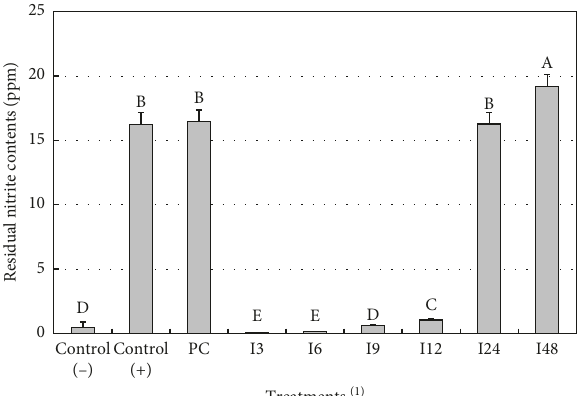
Figure 1: Changes of residual nitrite content of cooked cured pork loin with spinach juice and different incubating time. A − E Means with different letters are significantly different ( P < 0 . 05). (1) Control ( − ), curing meat with nitrite free; control (+), curing meat with 120ppm nitrite; PC, curing meat with preconverted nitrite source from spinach; I3,incubating for 3h curing meat with spinach and starter culture; I6, incubating for 6h curing meat with spinach and starter culture; I9, incubating for 9h curing meat with spinach and starter culture; I12, incubating for 12h curing meat with spinach and starter culture; I24, incubating for 24h curing meat with spinach and starter culture; I48, incubating for 48h curing meat with spinach and starter culture. (1) The difference between treatments was reported in the Materials and Methods section. Table 4: Changes of sensory evaluation of cooked cured pork loin with spinach juice and different incubating time. Treatments (1) Color Flavor Chewiness Overall acceptability Control ( −